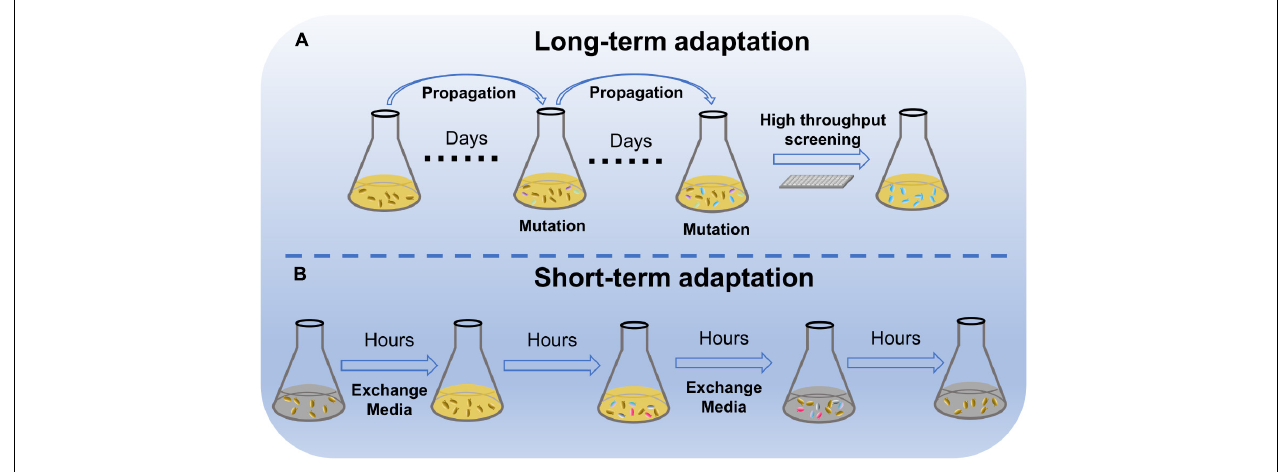
FIGURE 1 | Microbial stress adaptation. (A) Schematic diagram of long-term adaptation of microorganisms to their environment. (B) Schematic diagram of short-term adaptation of microorganisms to their